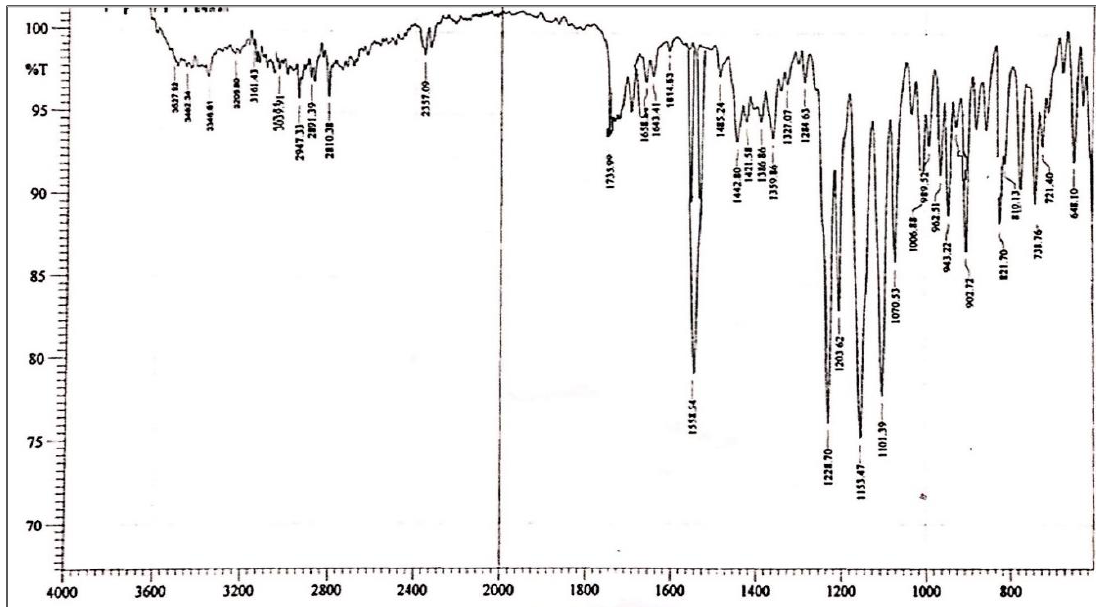
Figure 12.IR spectrum of isolated alkaloid.